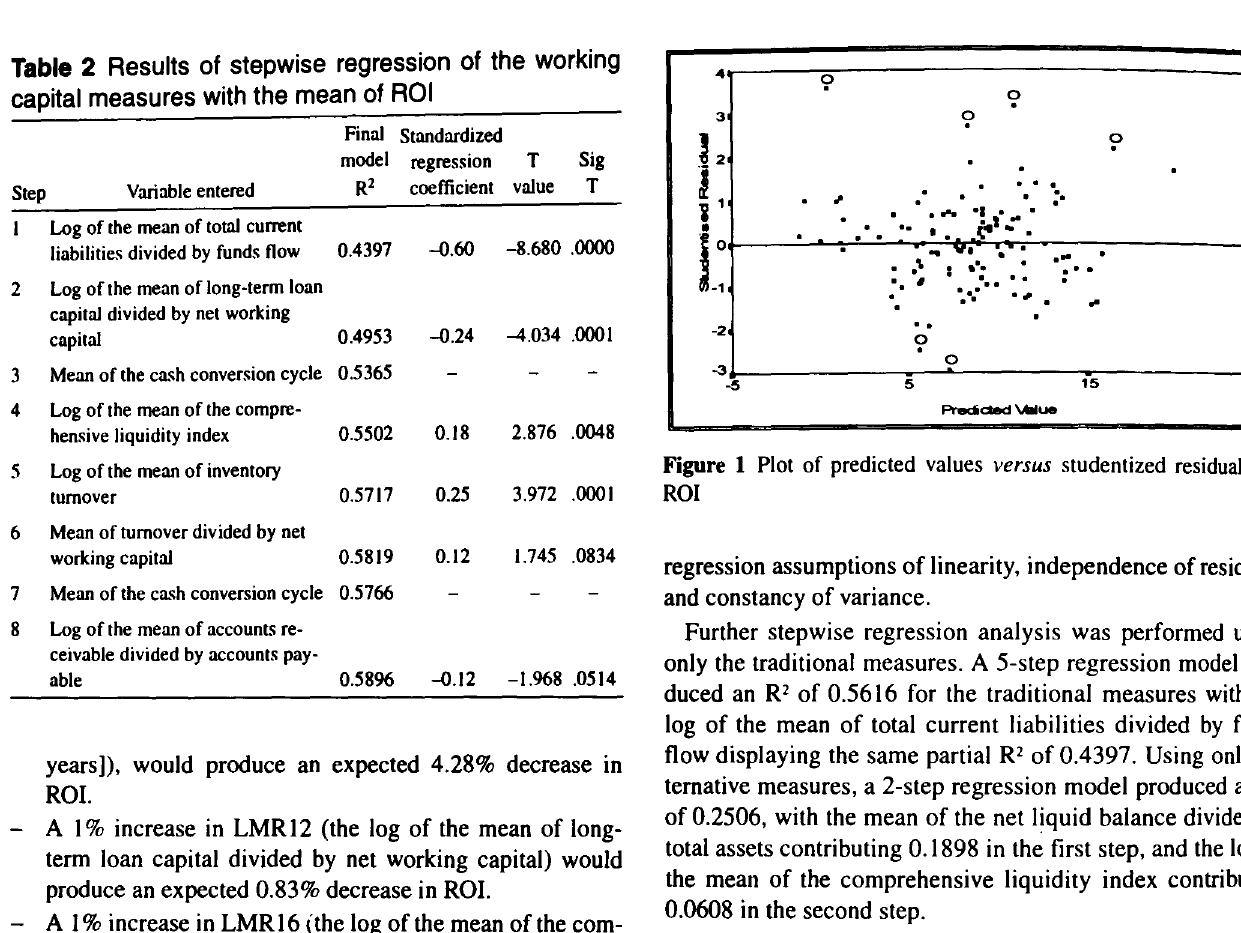
Table 2 Results of stepwise regression of the working capital measures with the mean of ROI